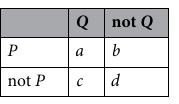
Table 1. Co-occurrence frequency information for event P and event Q